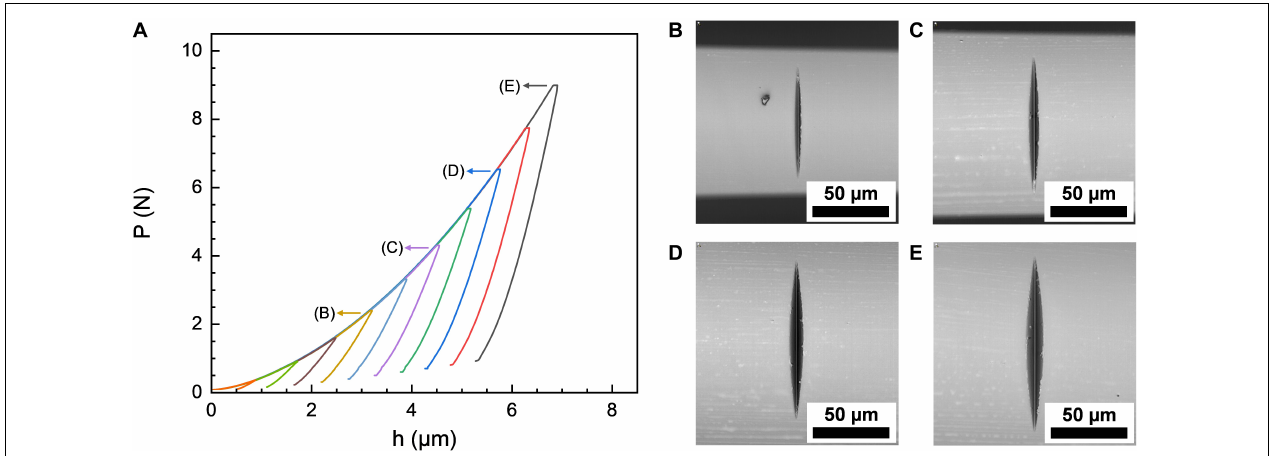
FIGURE 4 | (A) Representative load-displacement P - h curves recorded during wedge-indentation on a 440 µ m silica glass fiber using a wedge with an opening angle of 90 ◦ and an effective length of 215 µ m. Optical micrographs of the corresponding residual imprints (after unloading) are shown for indentations with maximum normal loads of (B) 2.34 N, (C) 4.26 N, (D) 6.52 N, and (E) 8.98